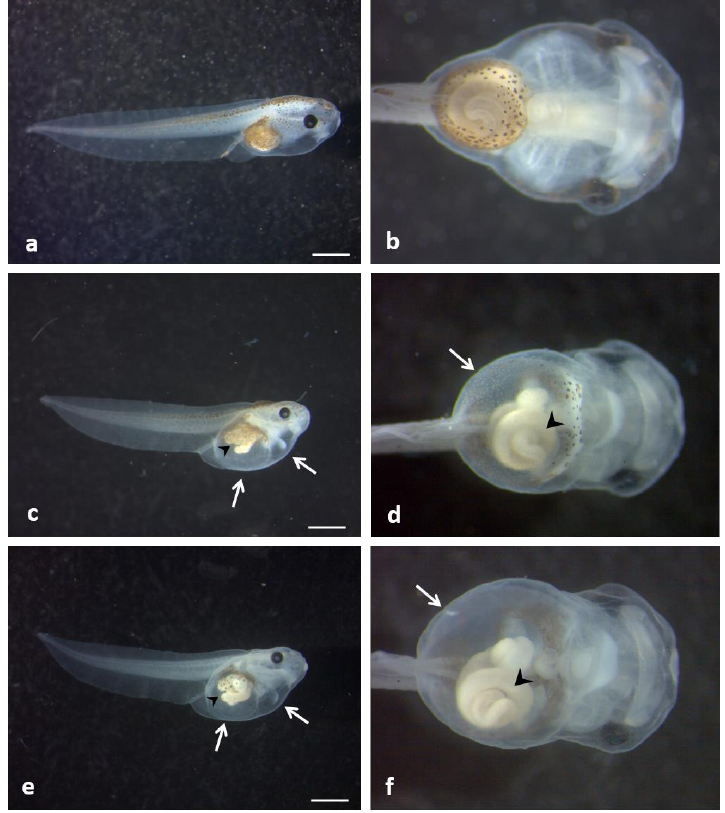
Figure 3. Xenopus laevis larvae at the end of the FETAX test. ( a ) Lateral and ( b ) ventral view of a control; ( c ) lateral and ( d ) ventral view of an embryo exposed to 50 mg /L sZnO; ( e ) lateral and ( f ) ventral view of an embryo exposed to 50 mg/L bZnO. The treated larvae show abnormal gut coiling (arrow head), abdominal and cardiac edemas (empty arrow) and a slight dorsal tail flexure. (b,d,f) Original magnification: 4×. Bars = 1